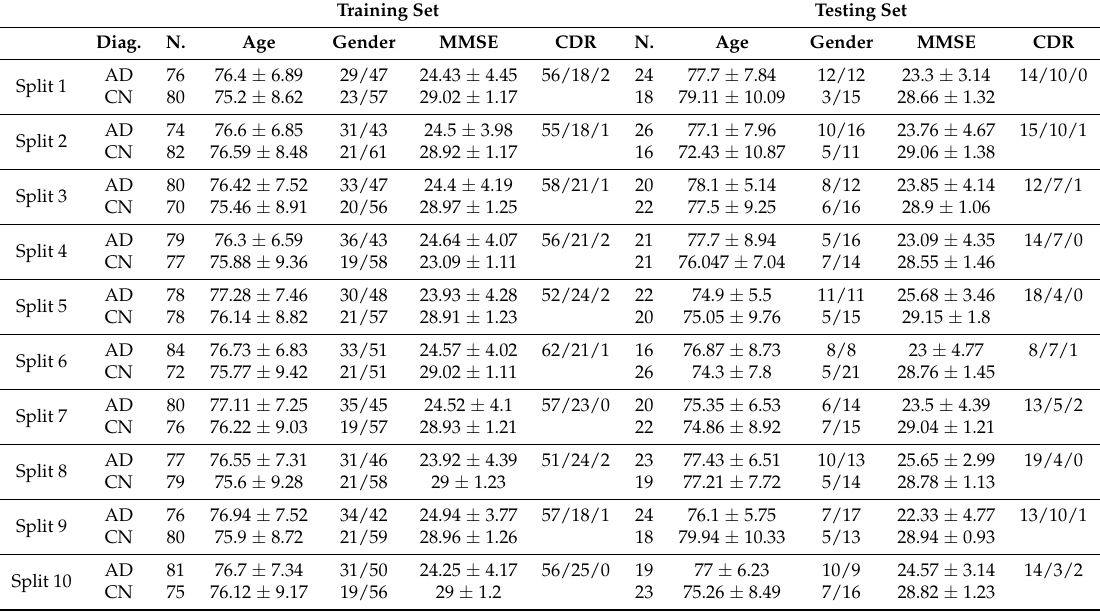
Table A1. Demographic information for each split of the aged 60 and over dataset. Gender is indicated as male/female, the Clinical Dementia Rating scale (CDR) values are indicated as the number or patients diagnosed as very mild dementia/mild dementia/moderate dementia. Age and Mini-Mental State Examination (MMSE) values are indicated as mean ± standard deviation. Training Set Testing Set Diag.